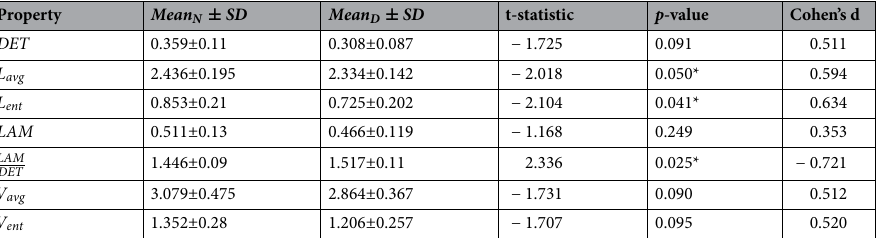
Table 4. Differences in means for the different recurrence plot measures for the non-depressed( n = 25 ) and depressed( n = 21 ) groups. The measures that show statistically significant ( p < .05 ) differences are indicated with an * DET : Determinism; L avg : Average diagonal line length; L ent : Entropy of diagonal line distribution; LAM : Laminarity; LAM DET : Laminarity to determinism ratio; V avg : Average vertical line length; V ent : Entropy of vertical line distribution, Mean N : Mean of the non-depressed group; Mean D : Mean of the depressed group; SD: Standard deviation.